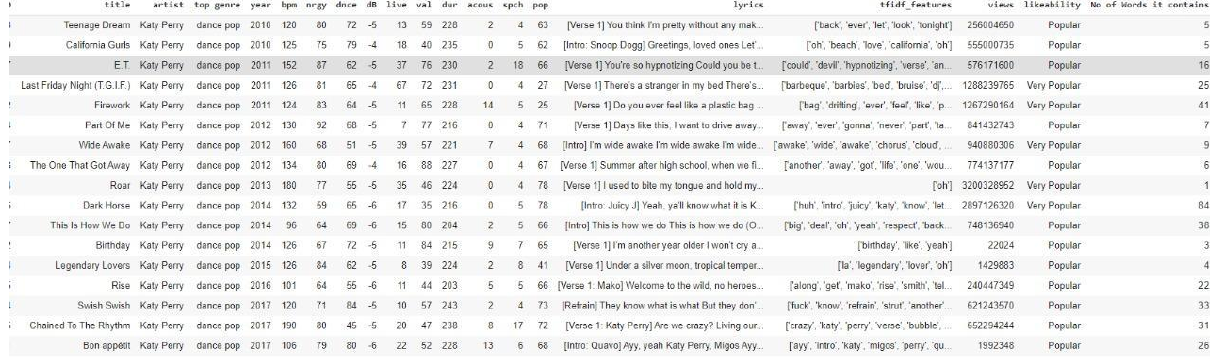
Figure 11. Table summarizing the Katy Perry’s Songs popularity based on the